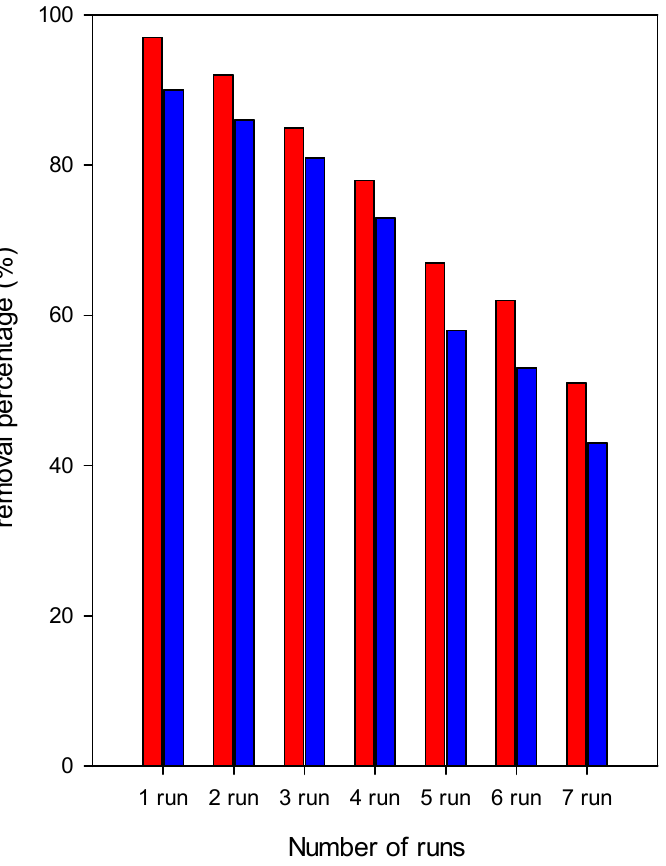
Figure 12. Regeneration properties of C 16 Br-CN (red) and C 16 OH-CN (blue) organoclays.